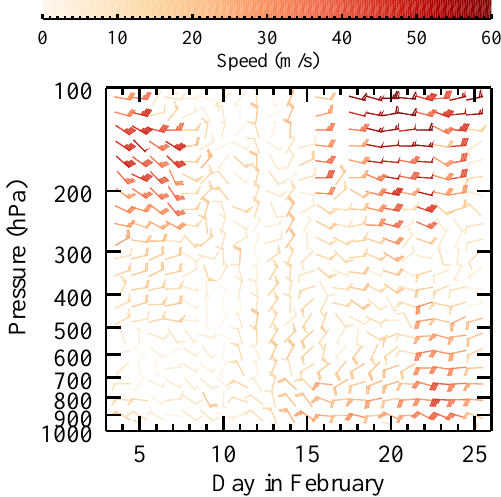
Figure 10. Wind speed (in ms − 1 ) and wind barbs (in knots), mea- sured by the CAST sondes between 0 and 18km. Note the easterly jet in the TTL between 19 and 21 February, coincident with the low ozone found in Fig. 11.